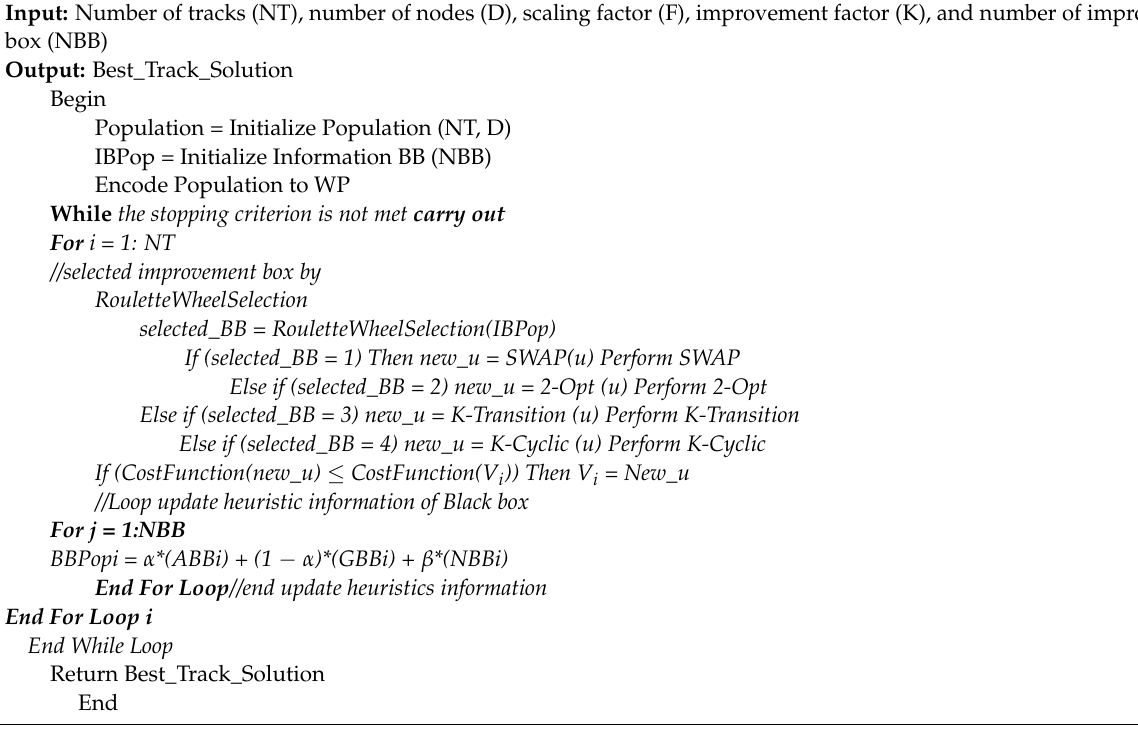
Algorithm A1. Adjusted variable neighborhood strategy adaptive search